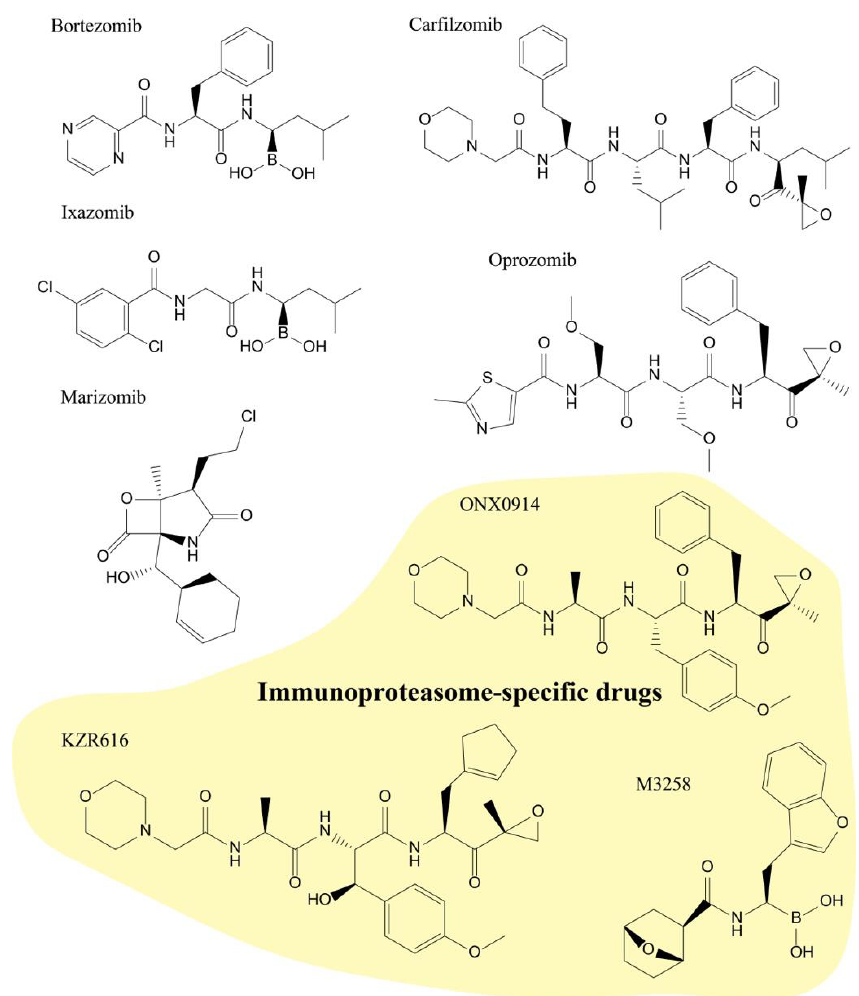
Figure 2. Clinical proteasome and immunoproteasome inhibitors. Chemical structures of clinically used proteasome and immunoproteasome inhibitors. For more information, see Tables 1 and 2.